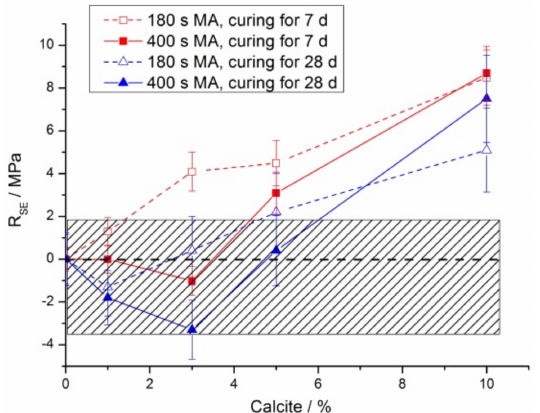
Figure 8. Increment of the synergistic effect (R SE ) in the strength of geopolymers based on the FA + calcite blends at the age of 7 and 28 days (calculated using data from [38]). The shaded area includes the data for which the R SE is close to zero.